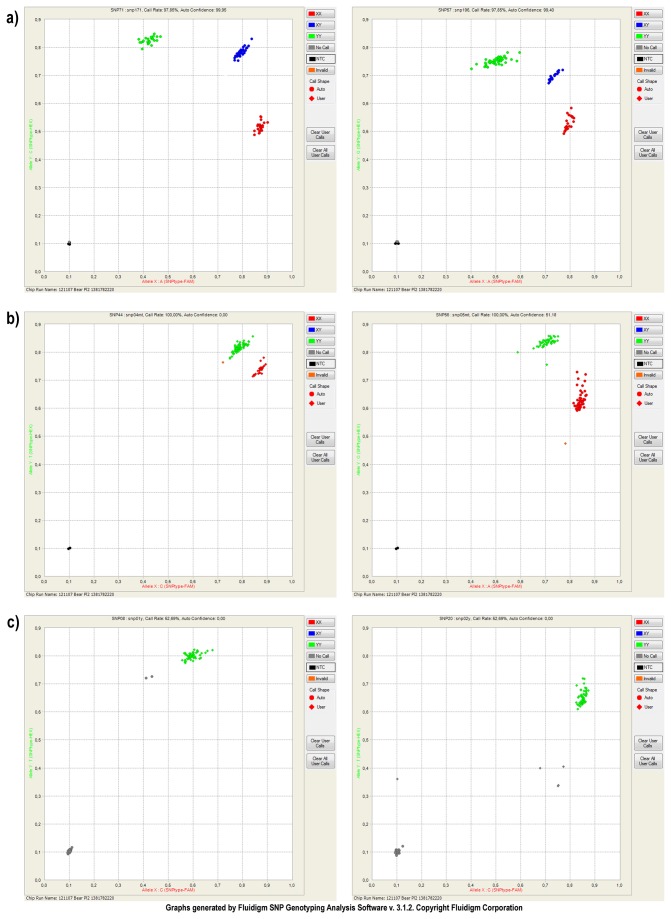
SNP Scatterplots.Scatterplots generated by the Biomark system (Fluidigm, San Francisco, USA) showing allelic clustering based on fluorescence for a) autosomal SNPs, b) mitochondrial haplotype markers, and c) Y-chromosome monomorphic sex-determination markers with male fluorescence.